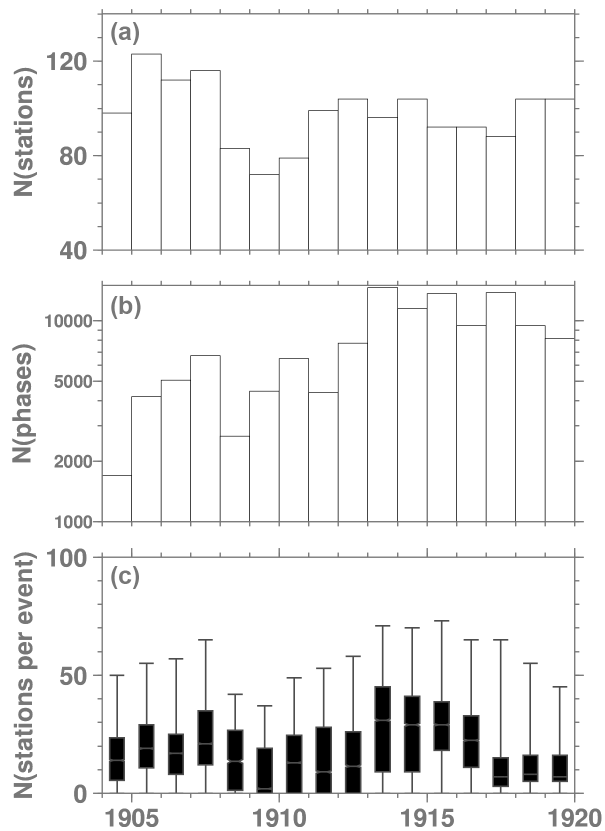
Figure 14. Annual number of station (a) , phases (b) and box-and- whisker plot (c) for the overall station data collected between 1904 and 1919.